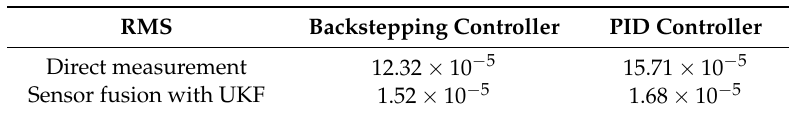
Table 6. RMS values of the signals.